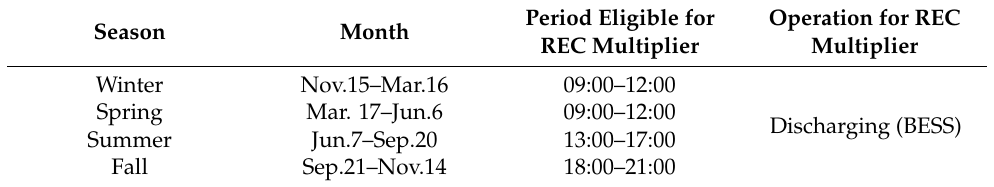
Table 5. Peak periods defined by the local SO for WPG–BESS operation in the Main Land.